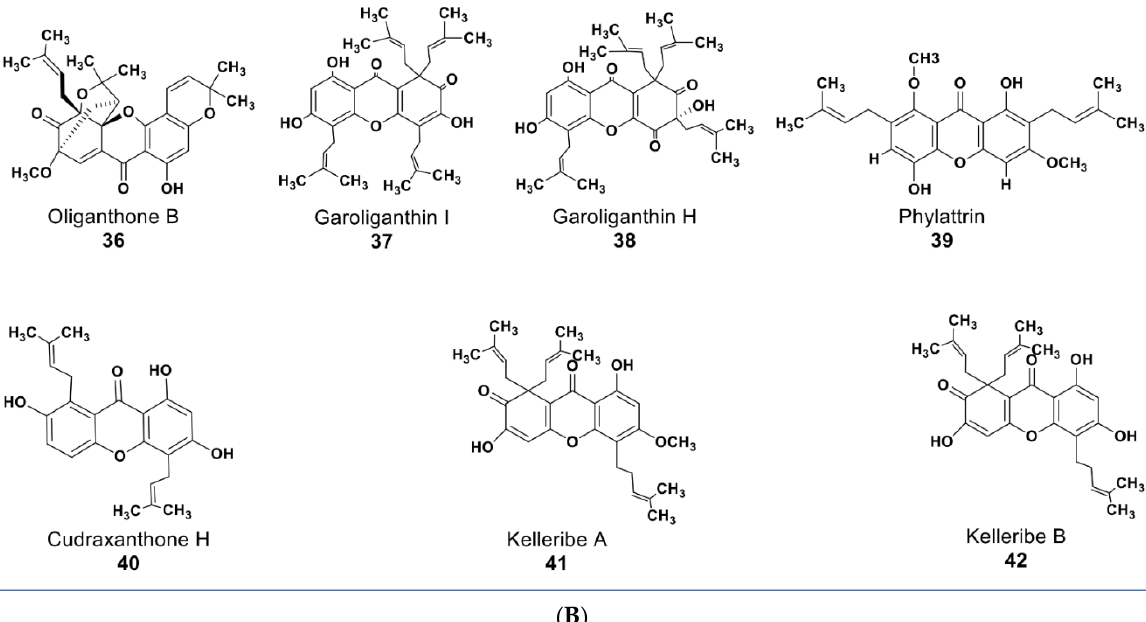
Figure 5. ( A ): Representative members of new xanthone phytochemicals from various plant sources (compounds 24 to 35 ). ( B ): Representative members of new xanthone phytochemicals from various plant sources (compounds 36 to 42 ).